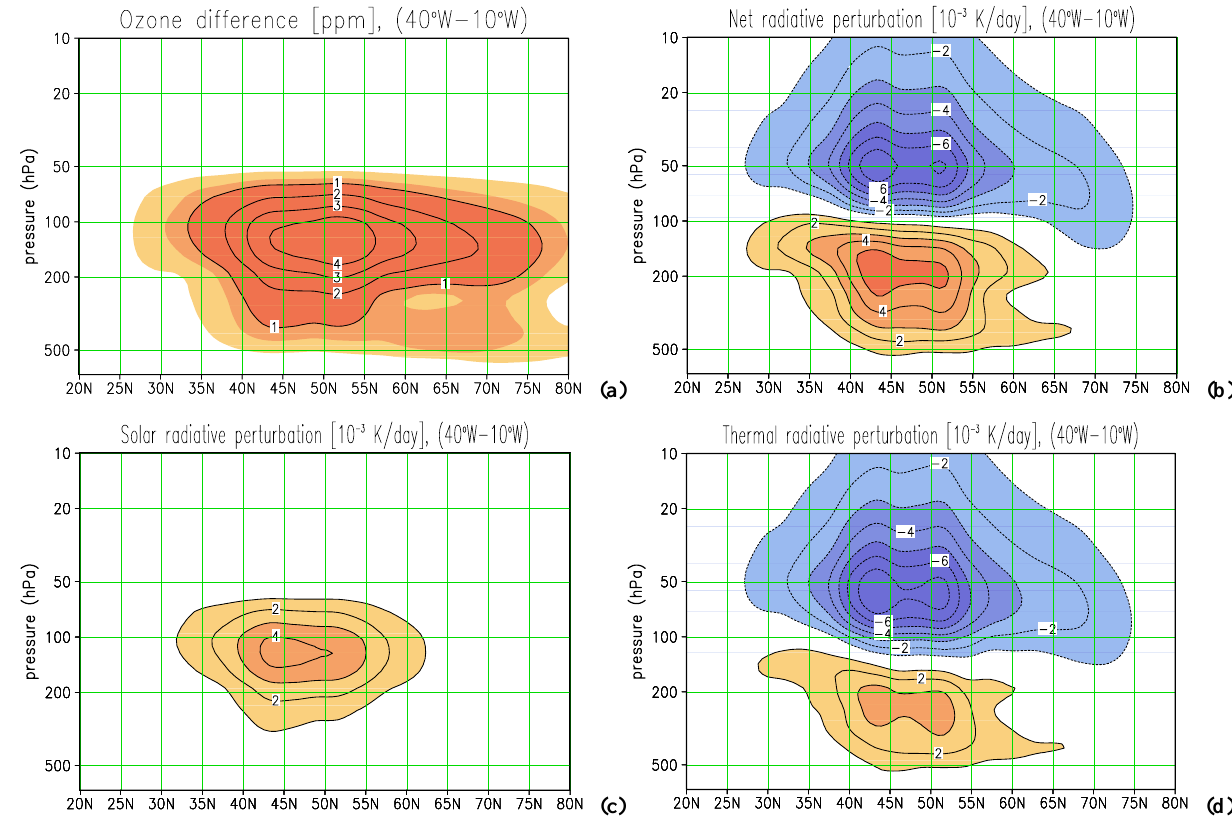
Fig. 2. Ozone anomaly and radiation forcing zonally averaged (40 ◦ W–10 ◦ W). Zonally averaged (40 ◦ W–10 ◦ W) vertical distribution of the ozone anomaly and radiation forcing of January averaged over 10 days: (a) Ozone difference, (b) Net radiation heating due to the ozone difference, (c) Same as (b) but only solar radiation heating, (d) Same as (b) but only thermal radiation